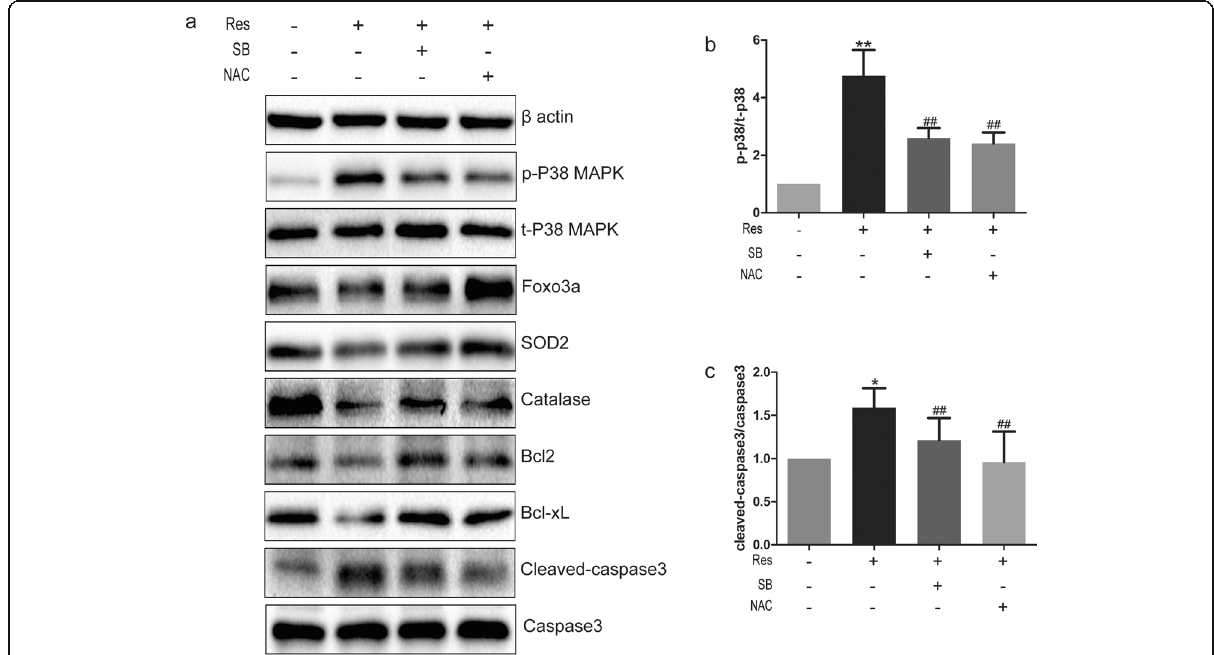
Fig. 4 Western blot analysis after co-incubating with SB203580 or NAC . a Western blot stripes of β actin, p-p38MAPK, p38MAPK, SOD2, Catalase, Foxo3a, Bcl2, Bcl-XL, Cleaved-caspase3, Caspase3. b, c Relative expression of p-38 or cleaved-caspase3 were analysed by student ’ s t -test. *P < 0.05,**P < 0.01 (compared with vehicle-treated control), ##P < 0.01 (compared with Res 30 μ M